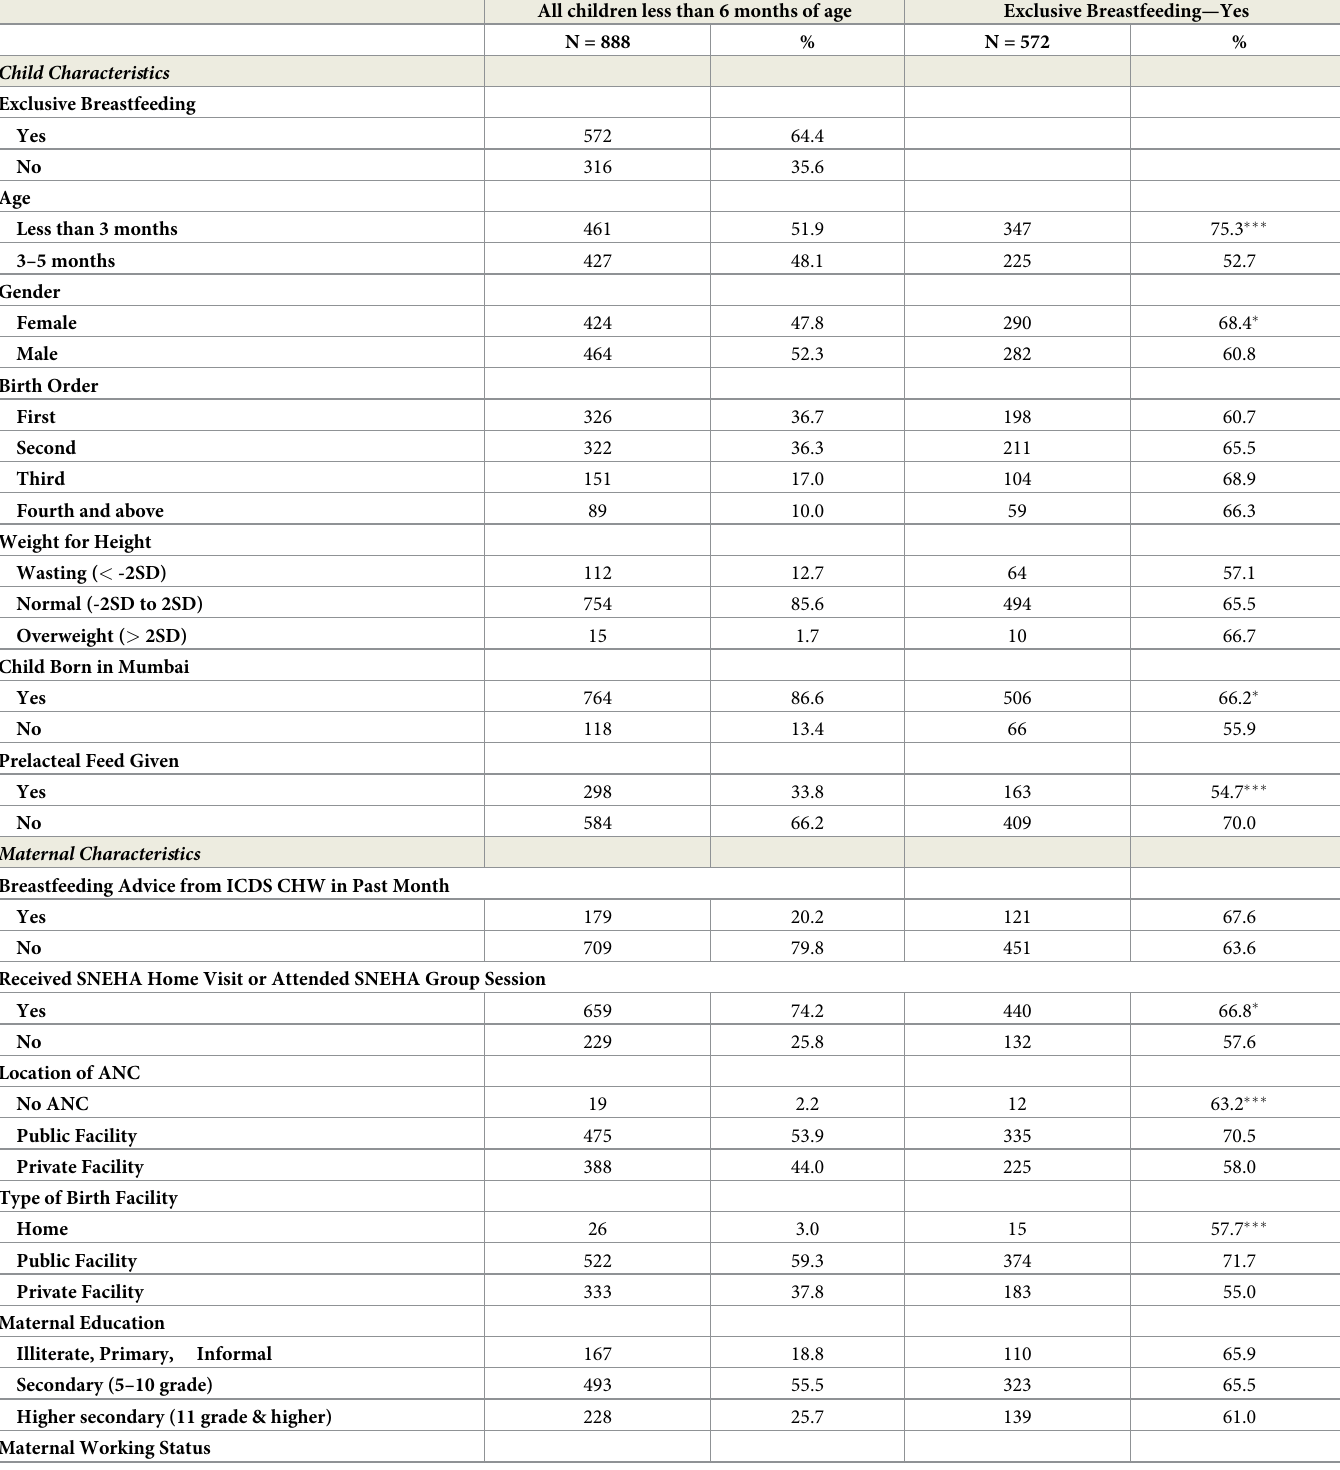
Table 1. Child, maternal, and socioeconomic characteristics and rates of exclusive breastfeeding by characteristic of infants under six months of age in informal set- tlements of Mumbai, India. All children less than 6 months of